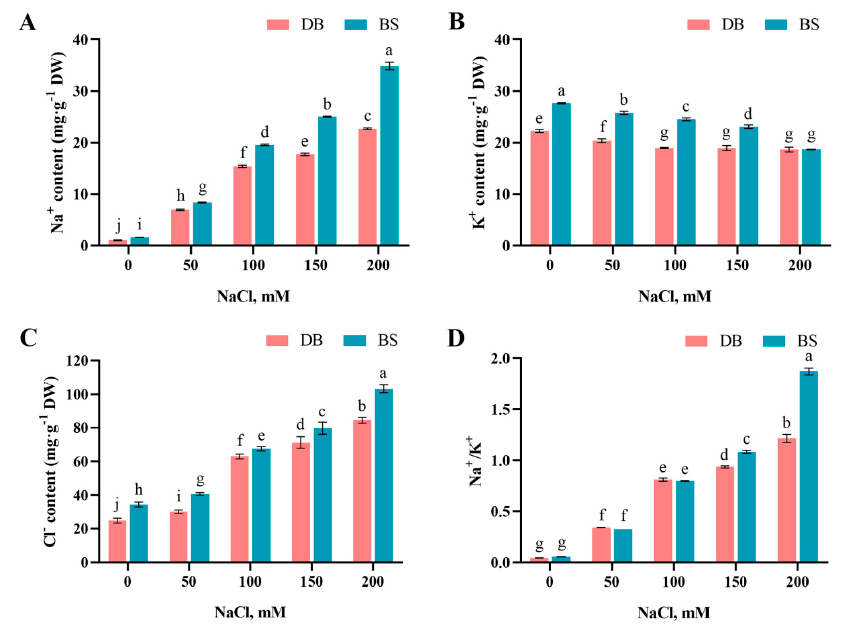
Figure 3. Effect of different NaCl concentrations on ( A ) Na + , ( B ) K + , ( C ) Cl − and ( D ) Na + /K + of H. syriacus ‘Duede Brabaul’ (DB) and H. syriacus ‘Blueberry Smoothie’ (BS). According to Duncan’s test, different lowercase letters (a–j) indicate significant differences ( p < 0.05) between different